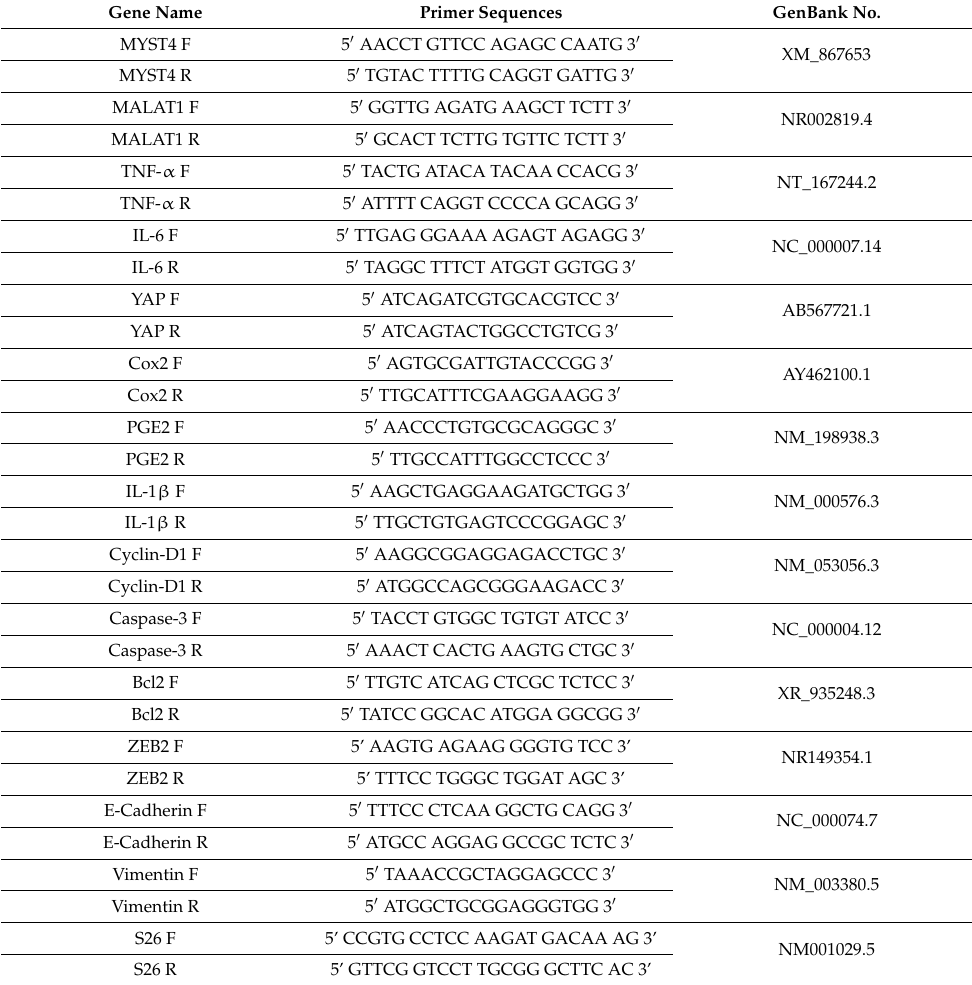
Table 1. Primer sequences used for the RT-qPCR